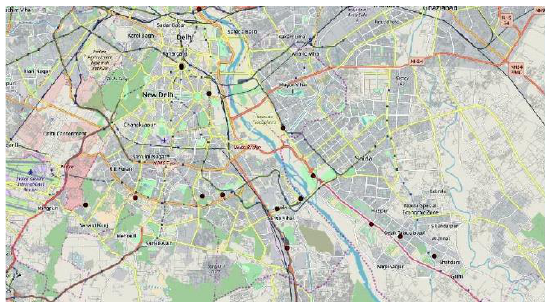
Figure-1 showing the study area and DGPS point as dotted. [Google Map]